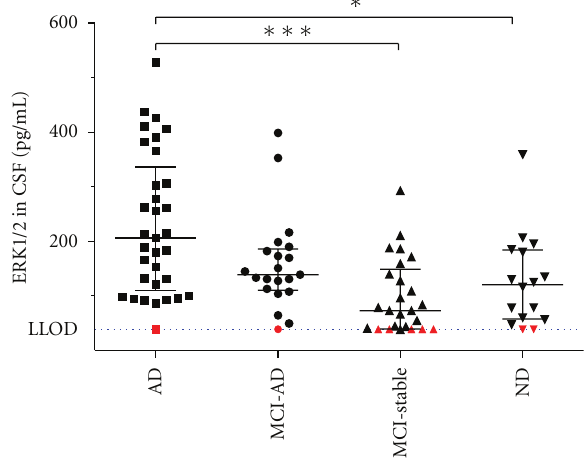
Figure 1: Scatterplot showing CSF levels of ERK1/2 in the 4 diagnostic groups. The bars indicate medians and the interquartile ranges. The red symbols indicate those 9 samples with signals below LLOD that are reported here arbitrarily as 39pg/mL. The di ff erences in rank sums between the AD and the ND groups and between AD and MCI-stable were statistically significant: ∗ P < 0 . 05, ∗∗∗ P < 0 . 001 (Kruskal-Wallis test followed by Dunn’s multiple comparison test). LLOD: mean lower limit of detection of ERK in undiluted CSF